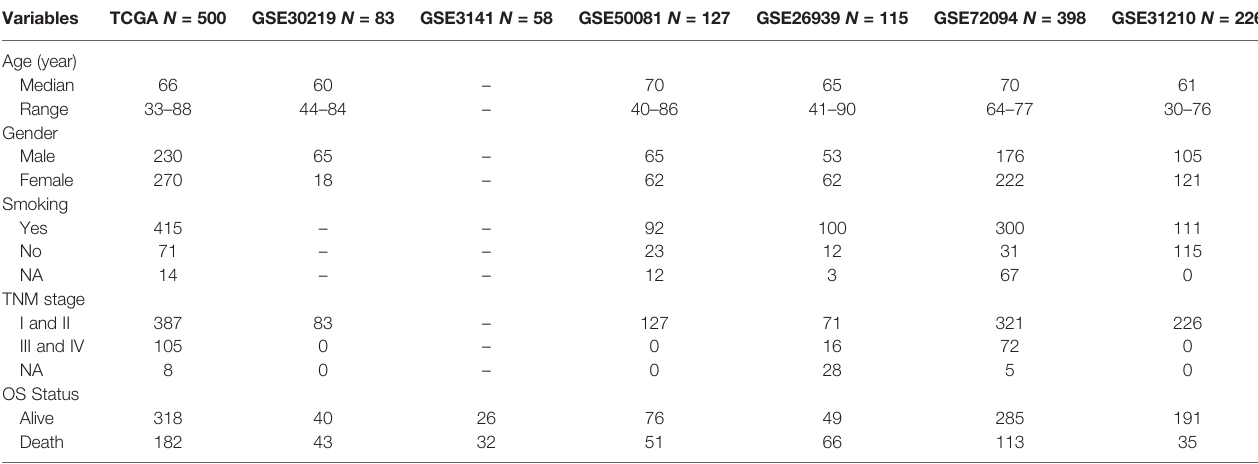
TABLE 1 | Clinical characteristics of lung adenocarcinoma from multiple